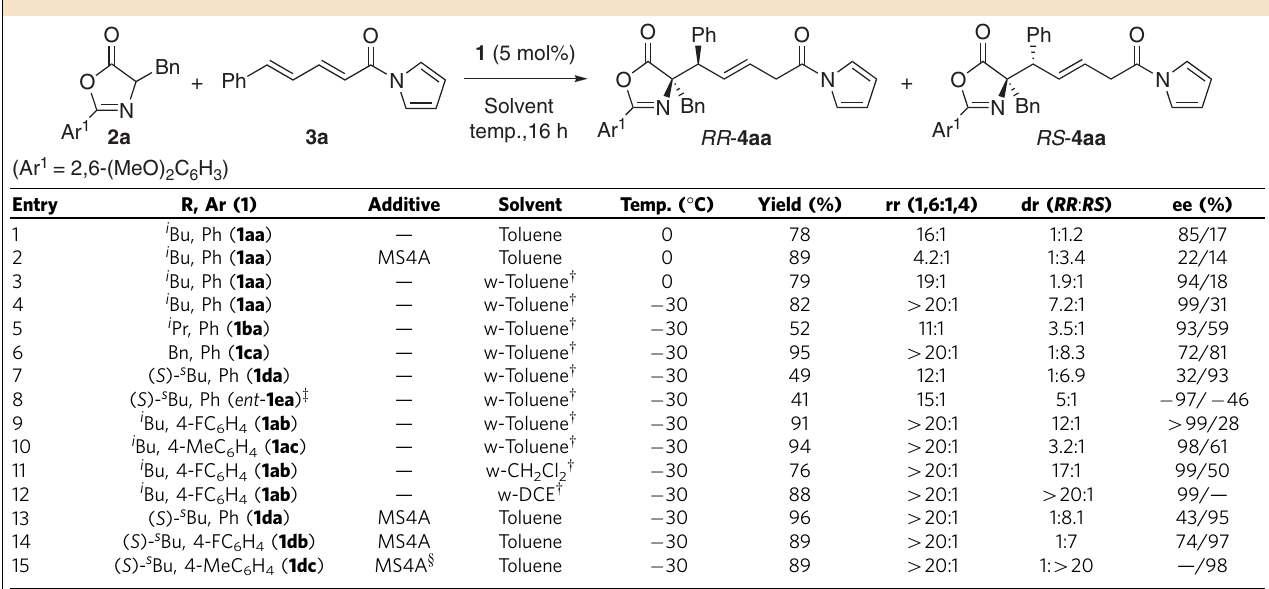
Table 1 | Optimization of reaction parameters*.